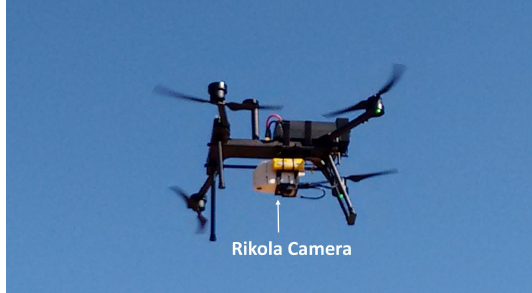
Figure 3. Computation of the pairs (Tx, Ty) in the accumulator matrix to select reliable matches.